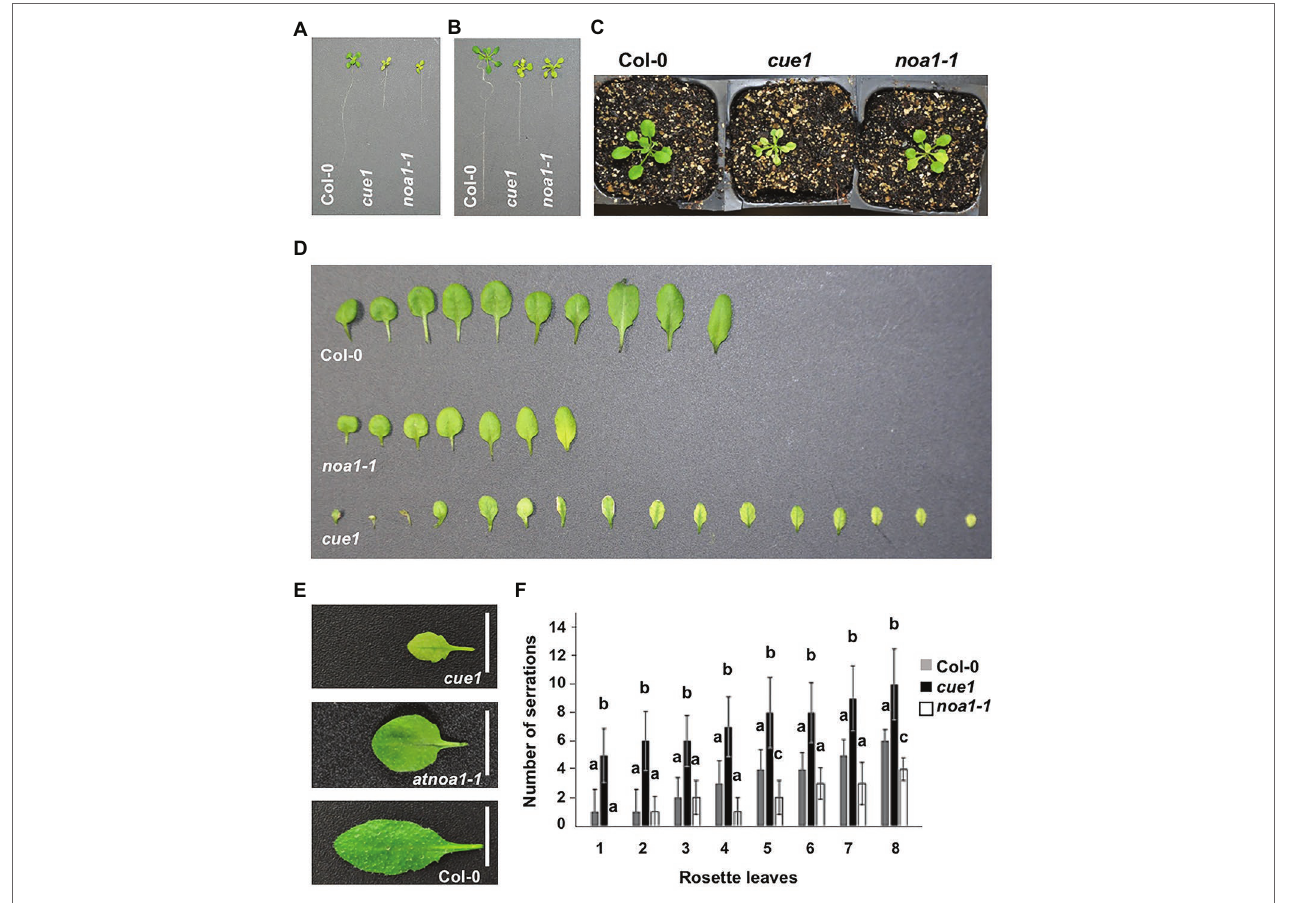
FIGURE 2 | Leaf phenotype of NO homeostasis mutants. Phenotype of 15-day-old seedlings (A) , 21-day-old seedlings (B) , 21-day-old plant rosettes (C) , and 30-day-old plant leaves (D,E) . Number of serrations in 30-day-old Arabidopsis leaves (F) . The developmental number of the leaf is represented on the X -axis and cotyledons are not included. Values represent the mean ± SD ( n = 10). Col-0, the ecotype used as a control is compared with the NO overproducer cue1/nox1 mutant and the NO deficient noa1-1